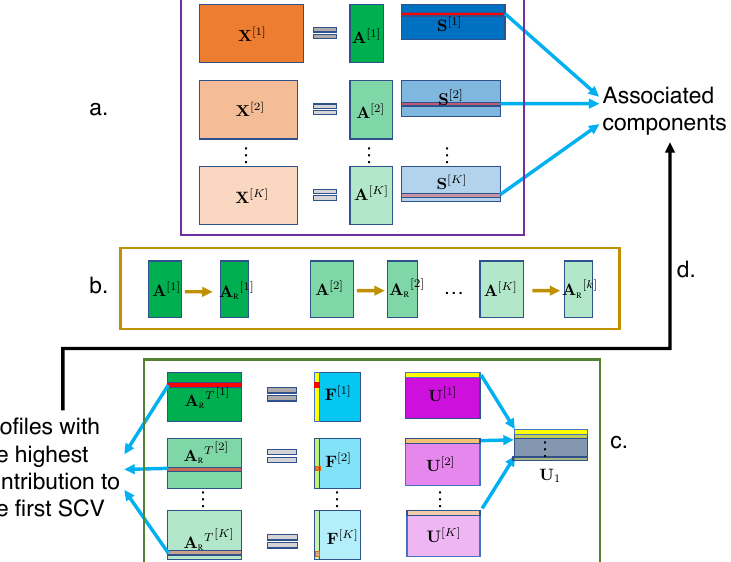
Figure 1. Flowchart of C-ICT. ( a ) Perform ICA on each dataset separately to obtain subject covariation matrices and ICs. ( b ) Eliminate subject covariations corresponding to artifact components. ( c ) Apply IVA-G on the reduced subject covariation matrices to obtain SCVs and the second-level mixing matrices. SCVs that show significant pair-wise correlation are chosen for further analysis. ( d ) Subject covariations with the highest contribution to the correlated SCVs chosen above are identified and their corresponding ICs are identified as the associated components across K modalities. The first SCV is highlighted for clarity. The same color of the bars in the different matrices denotes the same index in the corresponding rows and